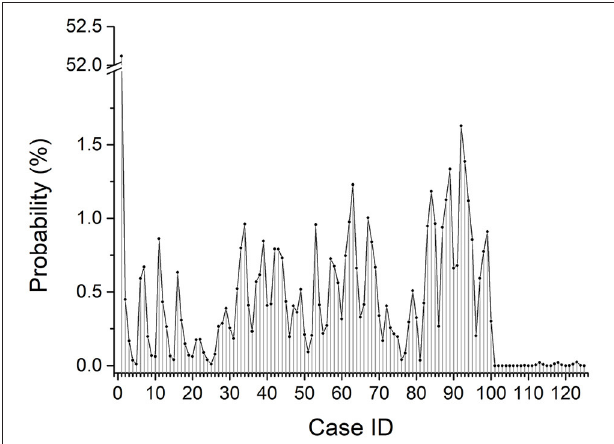
FIGURE 6 | Time probability distribution of two free rats in 125 relative posture positions (total time duration was 48h).